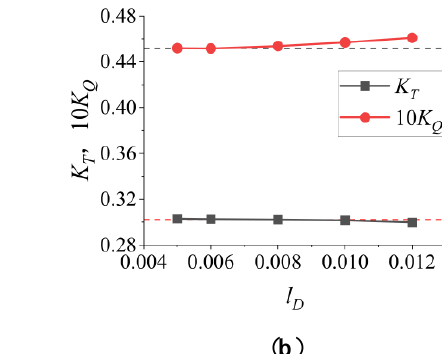
Figure 5. Mesh independence analysis of propellers Kap01 ( a ) and Kap04 ( b ) related to the base size of mesh.